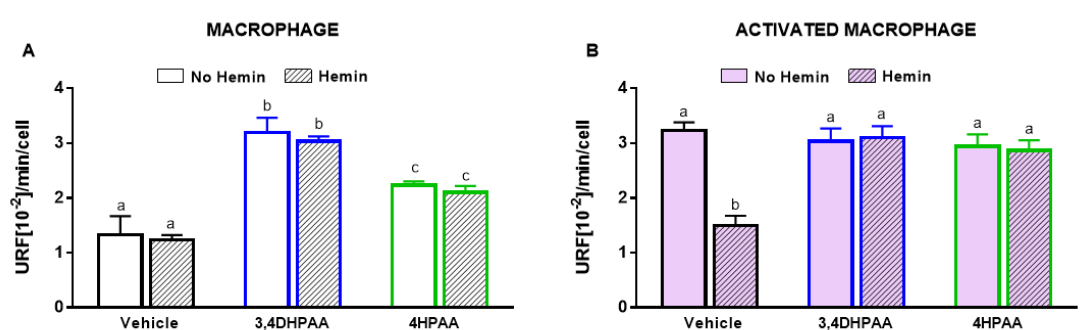
Figure 8. 3,4DHPAA and 4HPAA induce glycolysis in macrophages and hemin reduces glycolysis in activated macrophages. Glycolysis of ( A ) macrophages and ( B ) activated macrophages incubated with 10 µ M 3,4DHPAA or 10 µ M 4HPAA, in the presence or absence of 10 µ M hemin for 72 h. Values with di ff erent superscript letters (a, b and c) indicate significant di ff erences ( p < 0.05) between groups. For all bars with the same letter, the di ff erence between the means is not statistically significant. 3,4DHPAA, 3,4-dihydroxyphenylacetic acid; 4HPAA, 4-hydroxyphenylacetic